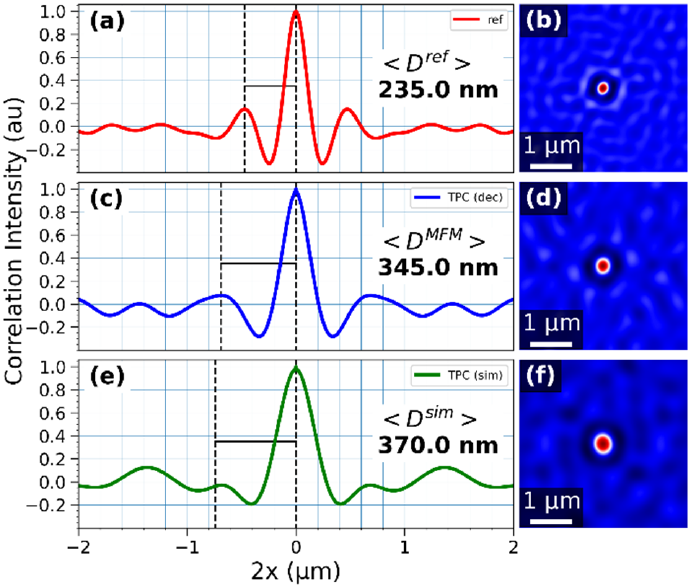
Figure A3. Plotlines through ( a , c , e ) the self-correlation transforms for the Co/Pt reference sample (ref) ( b ), the tpc reference sample (TPC (dec)) ( d ), and the simulated MFM image of the micromagnetic simulation results (TPC (sim)) ( f ).